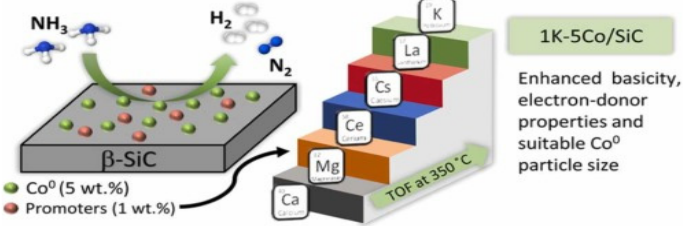
Figure 38. Cobalt-based catalysts, their support and promoters in ammonia decomposition. Reprinted with permission [133].